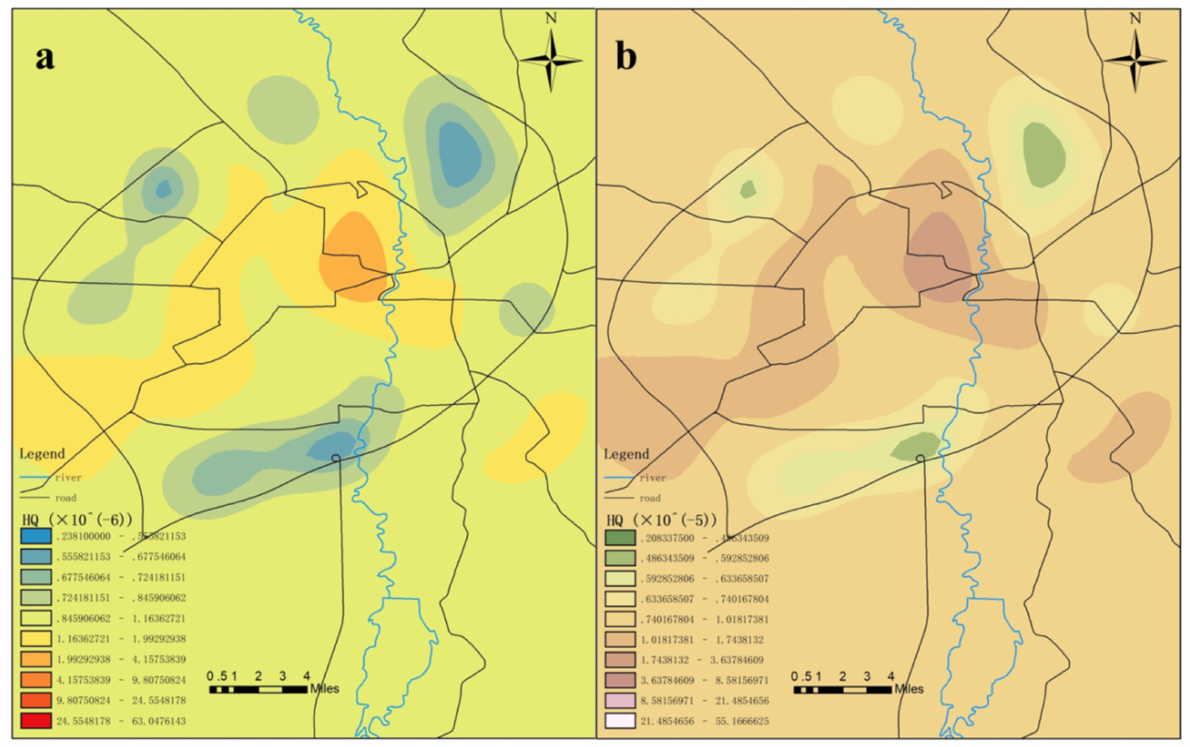
Figure 13. Distribution of the chronic non-carcinogenic indexes of mercury pollution in the surface soil for ( a ) adults and ( b )